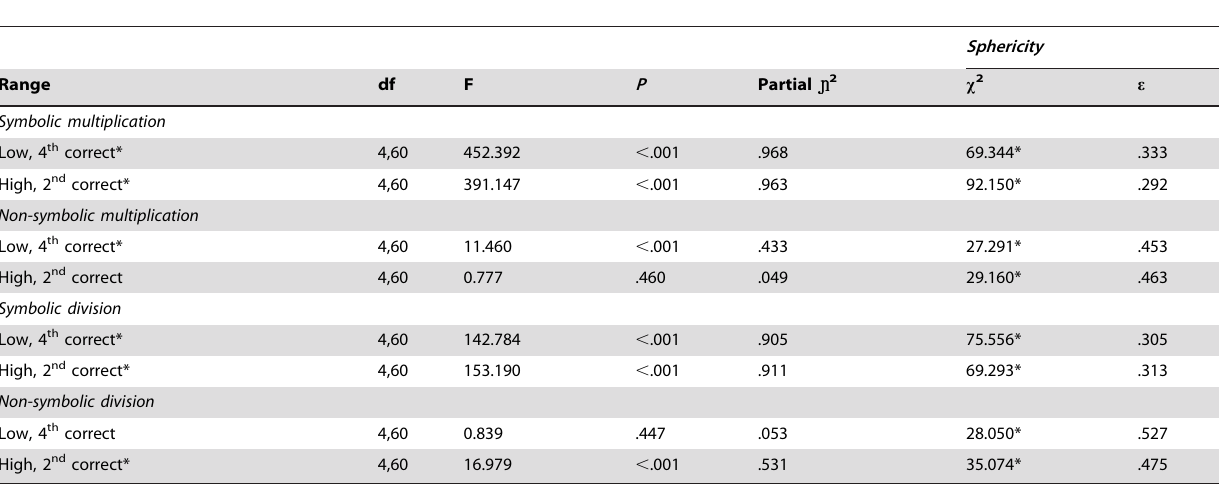
Table 2. Effect of response choice rank on response percentage for low and high